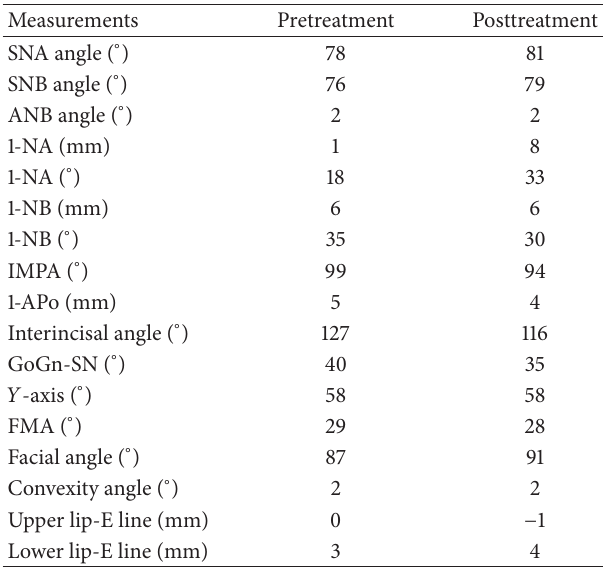
Table 1: Pre- and posttreatment